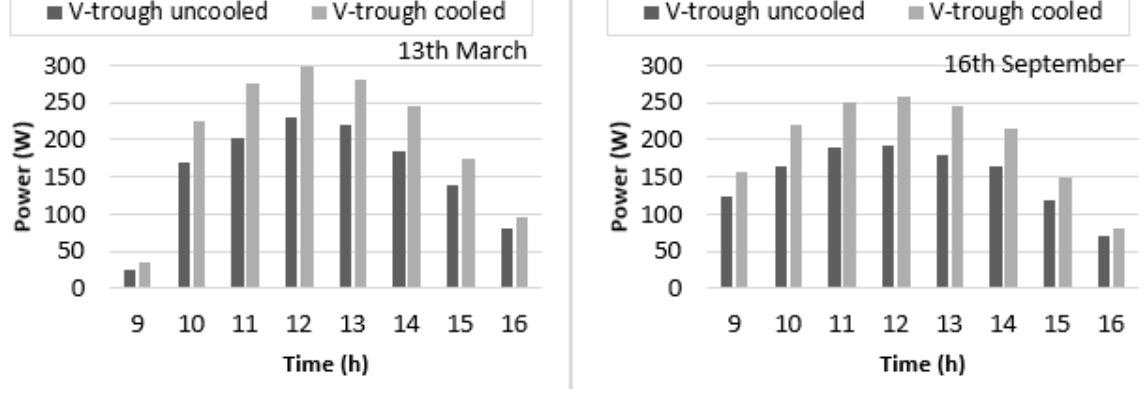
Figure 14. Comparison of power output for V-trough PV system with and without